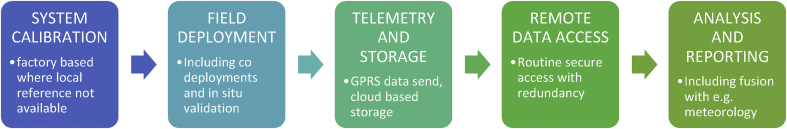
Schematic overview of novel reproducible protocols developed and employed for use of factory calibrated miniaturised OPCs in environments with limited AQ monitoring capabilities.